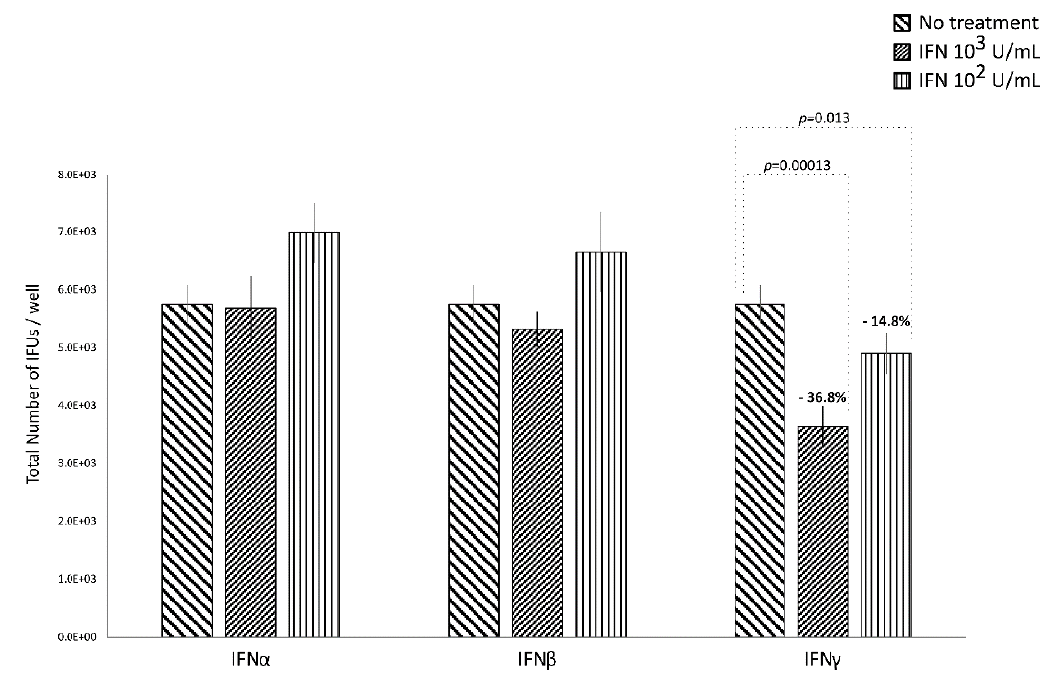
Figure 2. Anti-chlamydial activity of IFN α , IFN β , and IFN γ following the post-infection treatment of human synovial fibroblasts. Confluent monolayers were infected with C. trachomatis and, then, treated with the IFNs (10 2 or 10 3 IU / mL) for 24 h. The total number of Inclusion Forming Units (IFUs) was determined by fluorescence microscopy, counting all green-stained inclusions at 400 × magnification.